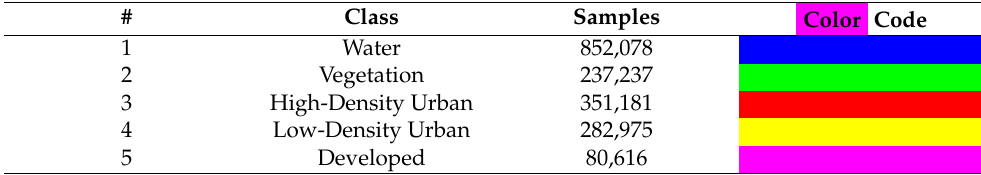
Table 10. Distribution of samples for the San Francisco dataset.